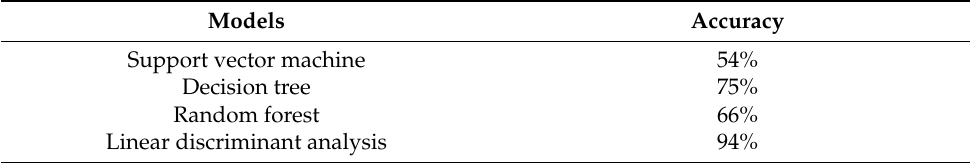
Table 2. Experiment 1.2